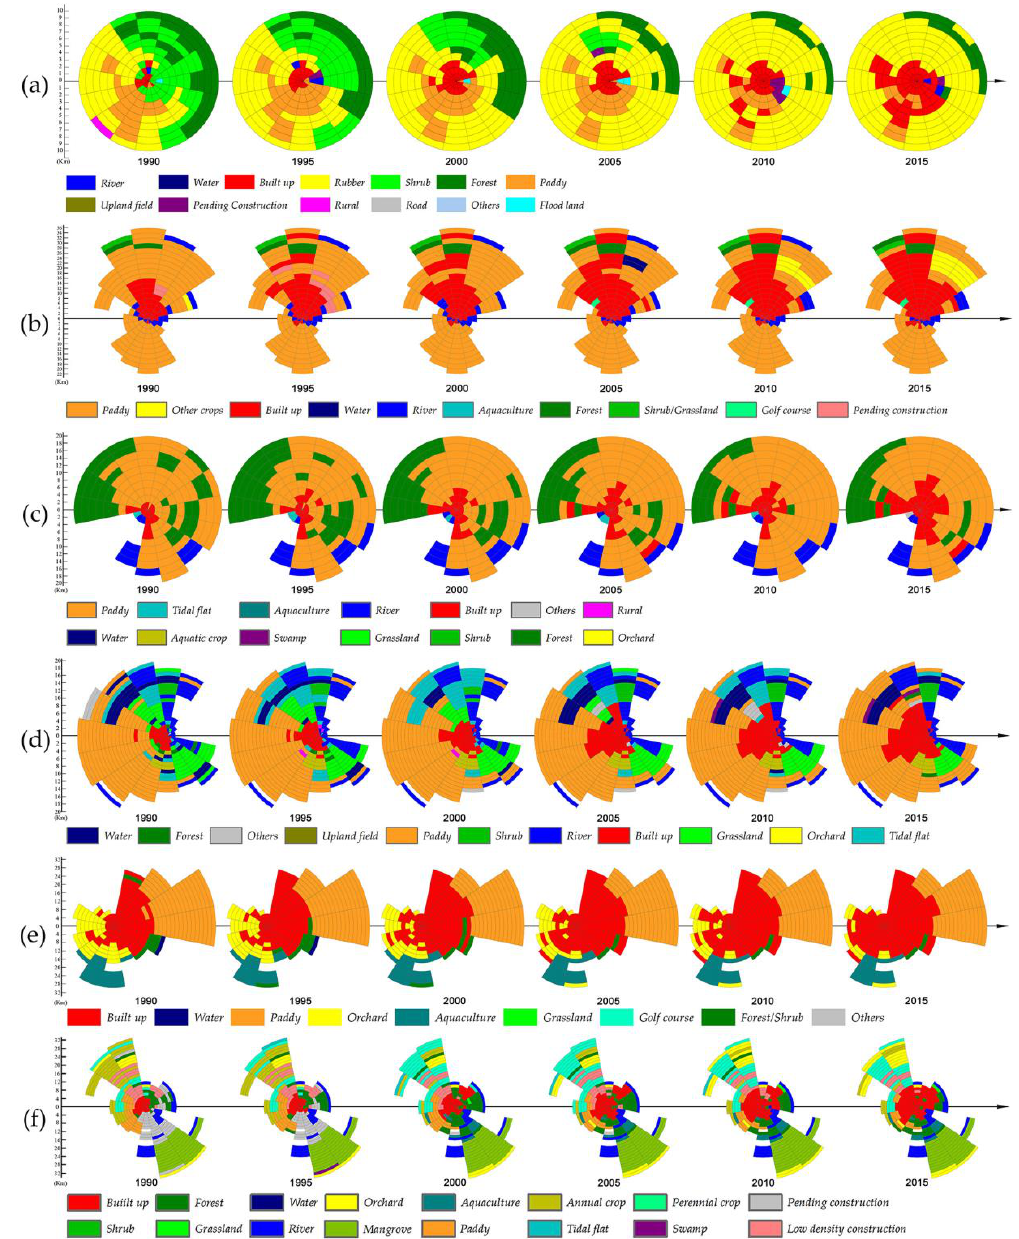
Figure 7. Gradient-direction maps of typical cities in the GMS in 1990, 1995, 2000, 2005, 2010, 2015, respectively (from left to right): ( a ) Xishuangbanna; ( b ) Yangon; ( c ) Vientiane; ( d ) Phnom Penh; ( e ) Bangkok; and ( f ) Ho Chi Minh City.